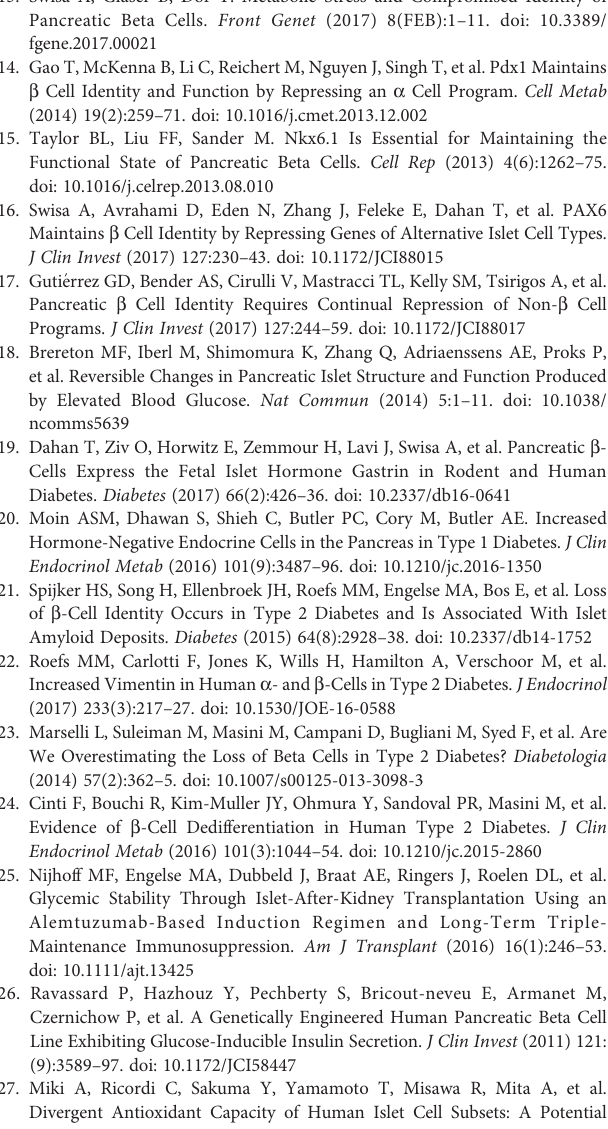
Supplementary Figure 1 | Schematic overview of the experimental setup and validationoftheH 2 O 2 treatments. (A) PrimaryhumanisletsorEndoC- b H1cellswere treated with 50 m M H 2 O 2 for 24 hours or with 200 m M H 2 O 2 for 90